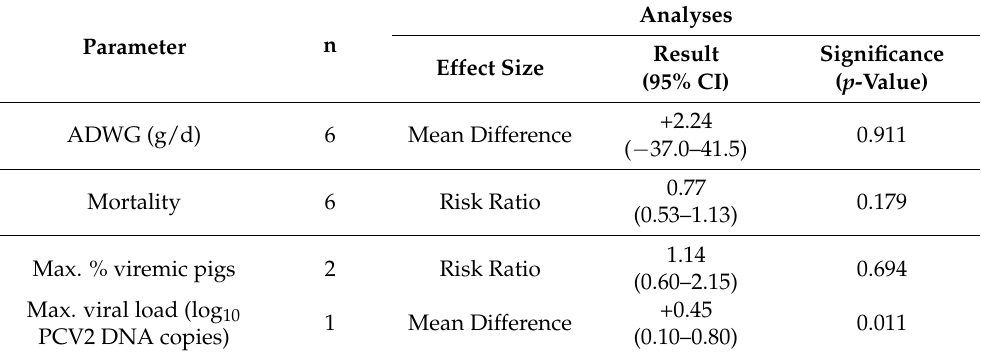
Table 6. Comparison of outcomes of production (ADWG and mortality) and virological parameters (maximum percentage of viremic pigs and maximum viral load in serum at any time point during the study observation period) between vaccinated pigs with high versus low to medium levels of MDA at the age of vaccination against PCV2.